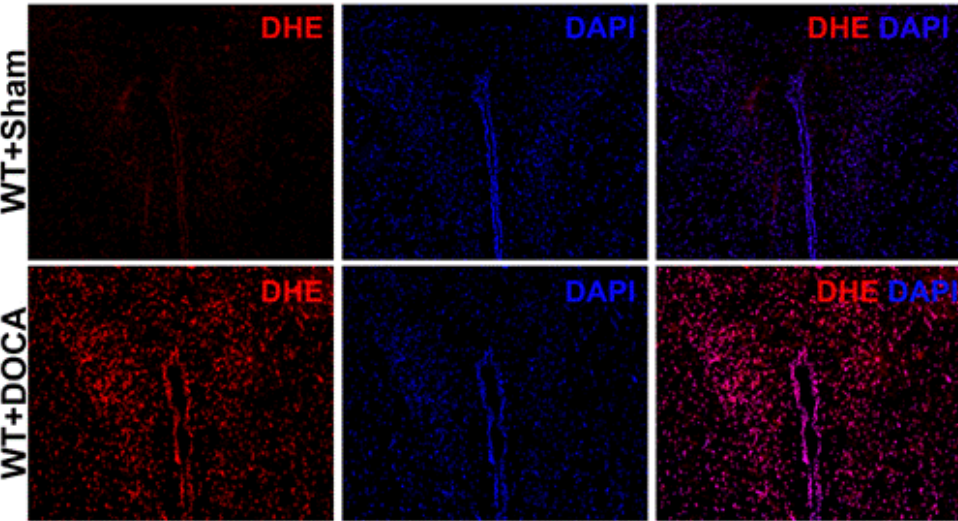
Figure 5. Elevated ROS production in the PVN during DOCA-salt hypertension. Representative images stained for DHE indicating increased ROS production in PVN of WT + DOCA mice compared to WT + Sham